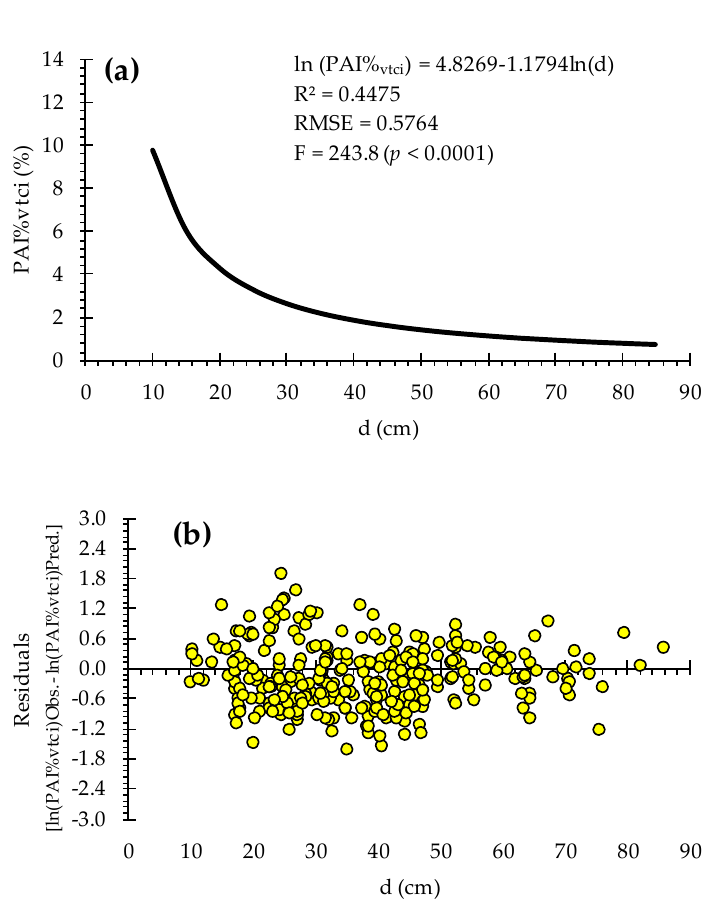
Figure 2. Adjusted equation for the annual percentage of volume increments up to the crown, with bark (PAI%vtci), ( a ) and graphical analysis of the residues showing a regular distribution ( b ) of A. angustifolia (Bertol.) Kuntze. Table 1. Simulation of different scenarios, varying the values of Liocourt’s quotient (q = 1.1, 1.3, 1.5) and of the remaining basal area (Grem = 10.0, 14.0, 18.0), aiming at the sustainable management of A. angustifolia (Bertol.) Kuntze in Lages, SC.